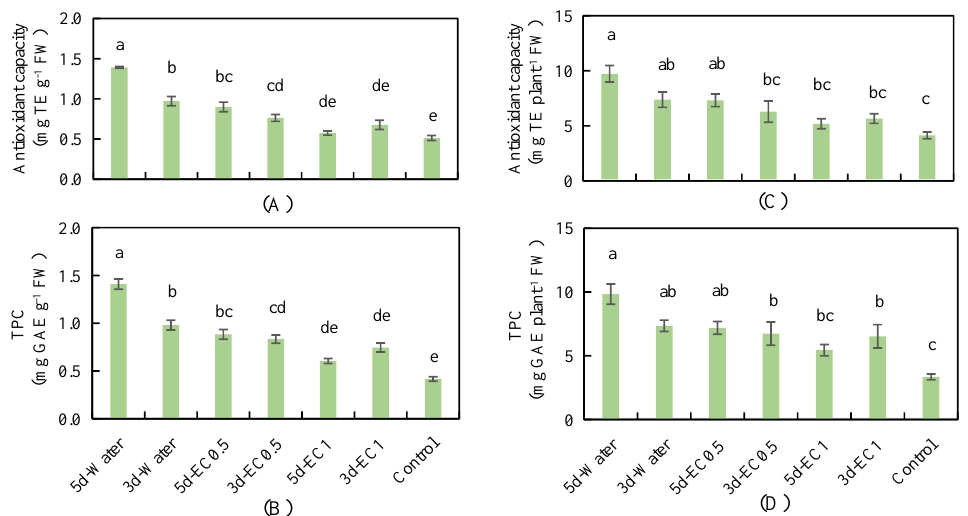
Figure 5. The antioxidant capacity in basil leaves ( A ), total phenolic content (TPC) in basil leaves ( B ), antioxidant capacity in leaves of the whole plant ( C ), and TPC in leaves of the whole plant ( D ) under different EC treatments at 34 days after sowing. The error bars represent SEs ( n = 8). Different lowercase letters represent significant differences among different EC treatments based on Tukey’s new multiple range test at p < 0.05.